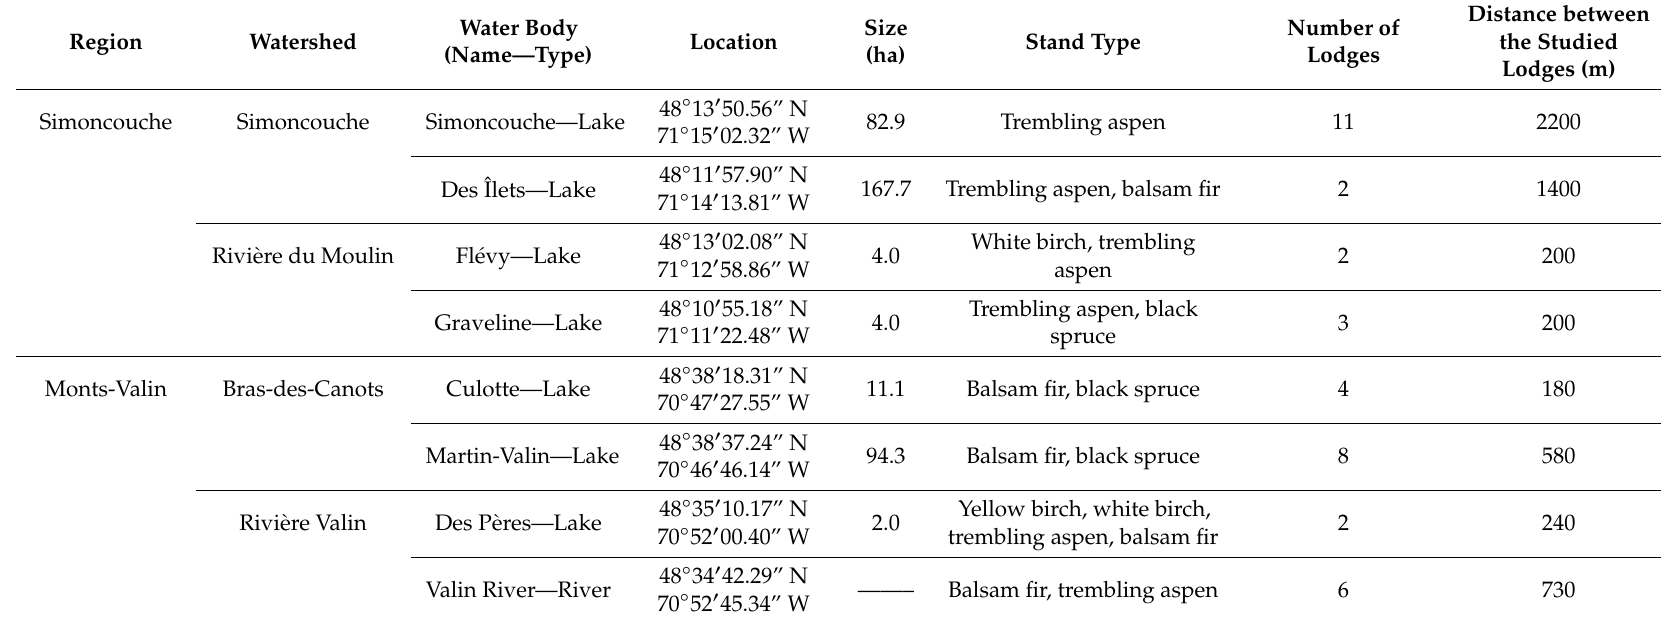
Table 1. Main characteristics of the studied water